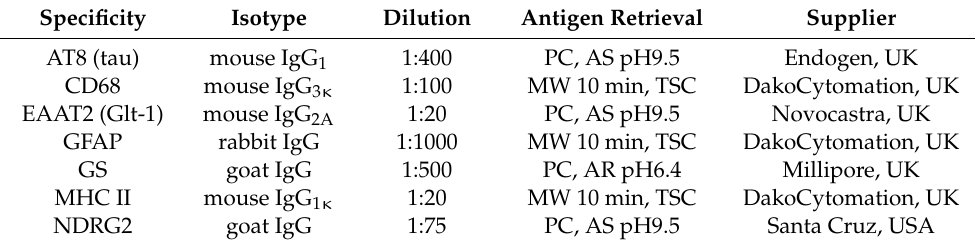
Table 2. Antibody source and